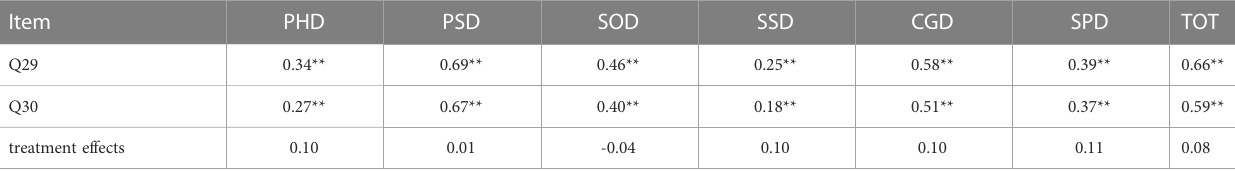
PHD, physical domain; PSD, psychological domain; SOD, social domain; SSD, common symptoms and side effect domain; CGD, core/general module; SPD, speci fi c domain; TOT, the total. **P<